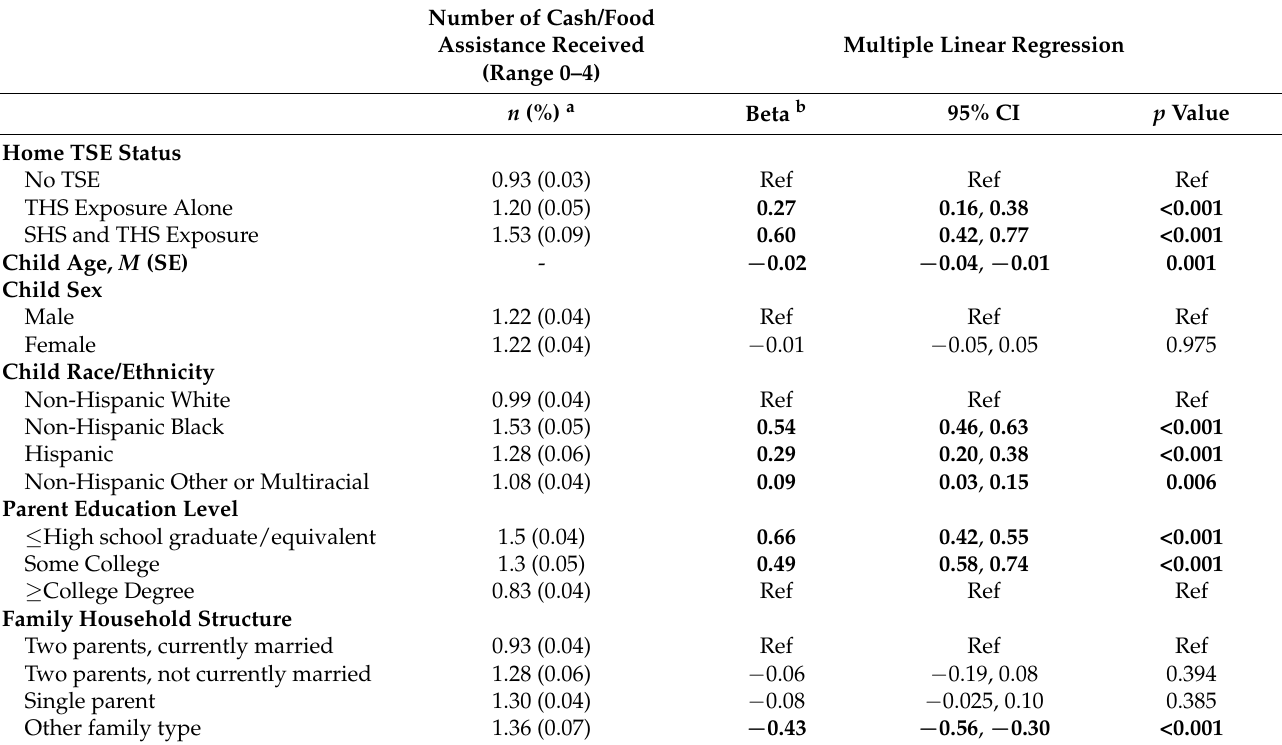
Table 3. Child Home TSE Status and Number of Instances of Cash or Food Assistance Items